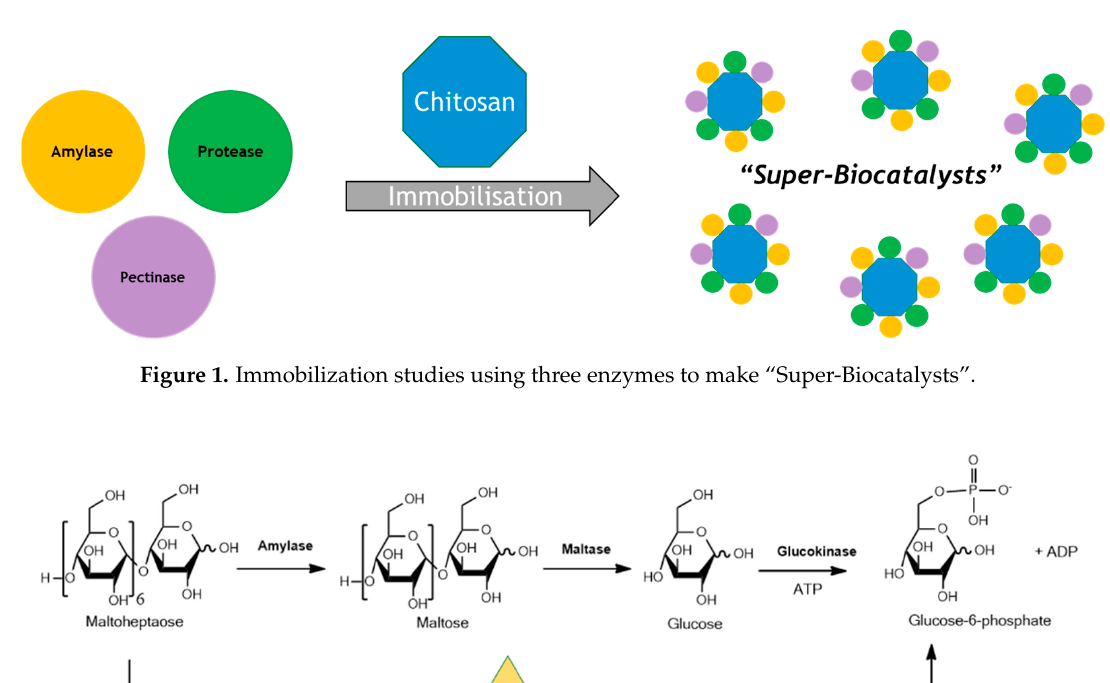
Figure 1. Immobilization studies using three enzymes to make “Super ‐ Biocatalysts”.